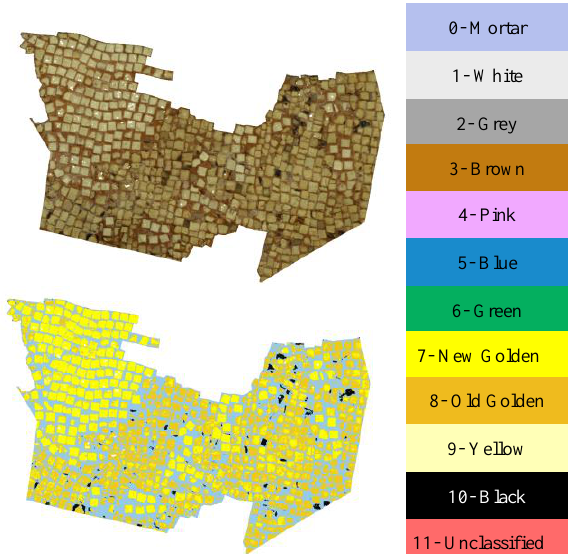
Figure 11. Qualitative results: From top to bottom; raw point cloud, prediction results (using